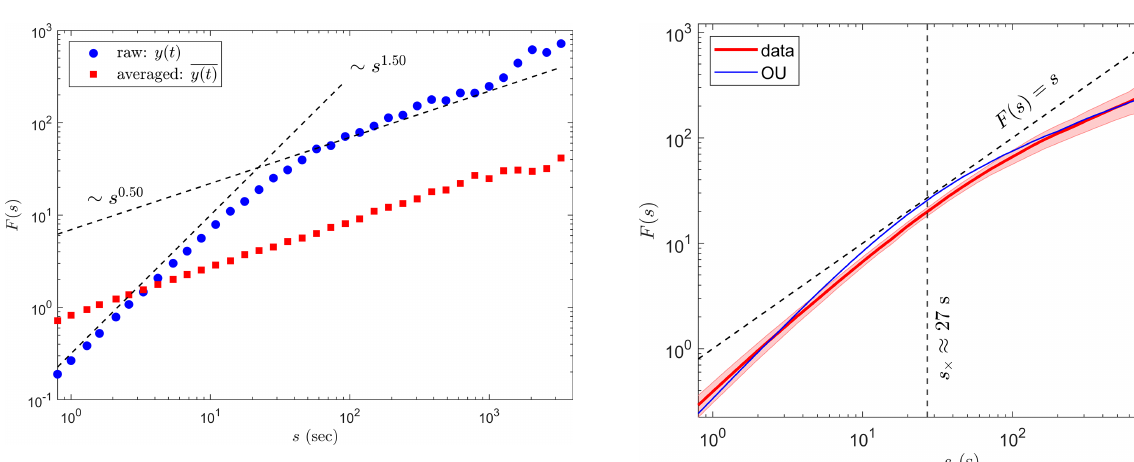
Figure 5. The DFA of the time series shown in Fig. 4. The fluctu- ation functions of the unaveraged and averaged time series are de- noted by blue circles and red rectangles, respectively. The theoreti- cal predictions of the OU process are also denoted by broken lines (Höll and Kantz, 2015; Czechowski and Telesca, 2016; Løvsletten, 2017).